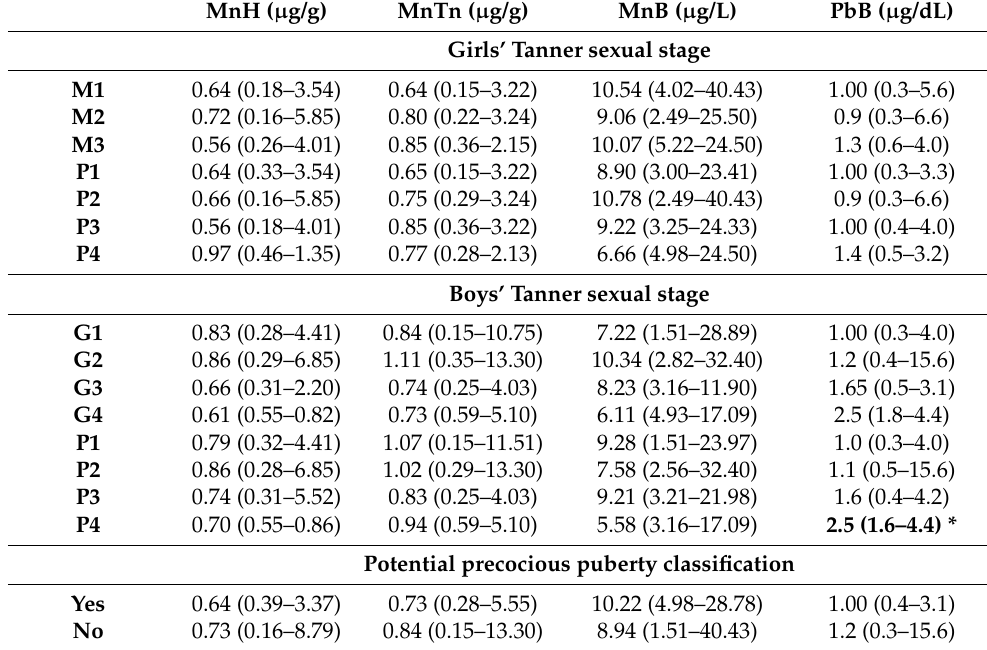
Table 4. Children’s biomarkers of exposure expressed in median (minimum–maximum) by each Tanner’s sexual maturation stage and potential precocious puberty